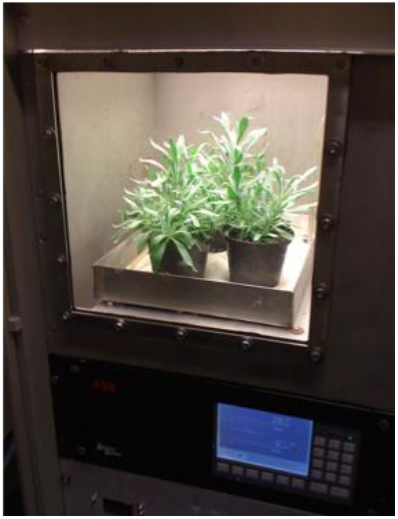
Figure 10. Gas chamber for incubation of plants with 13 CO 2 .